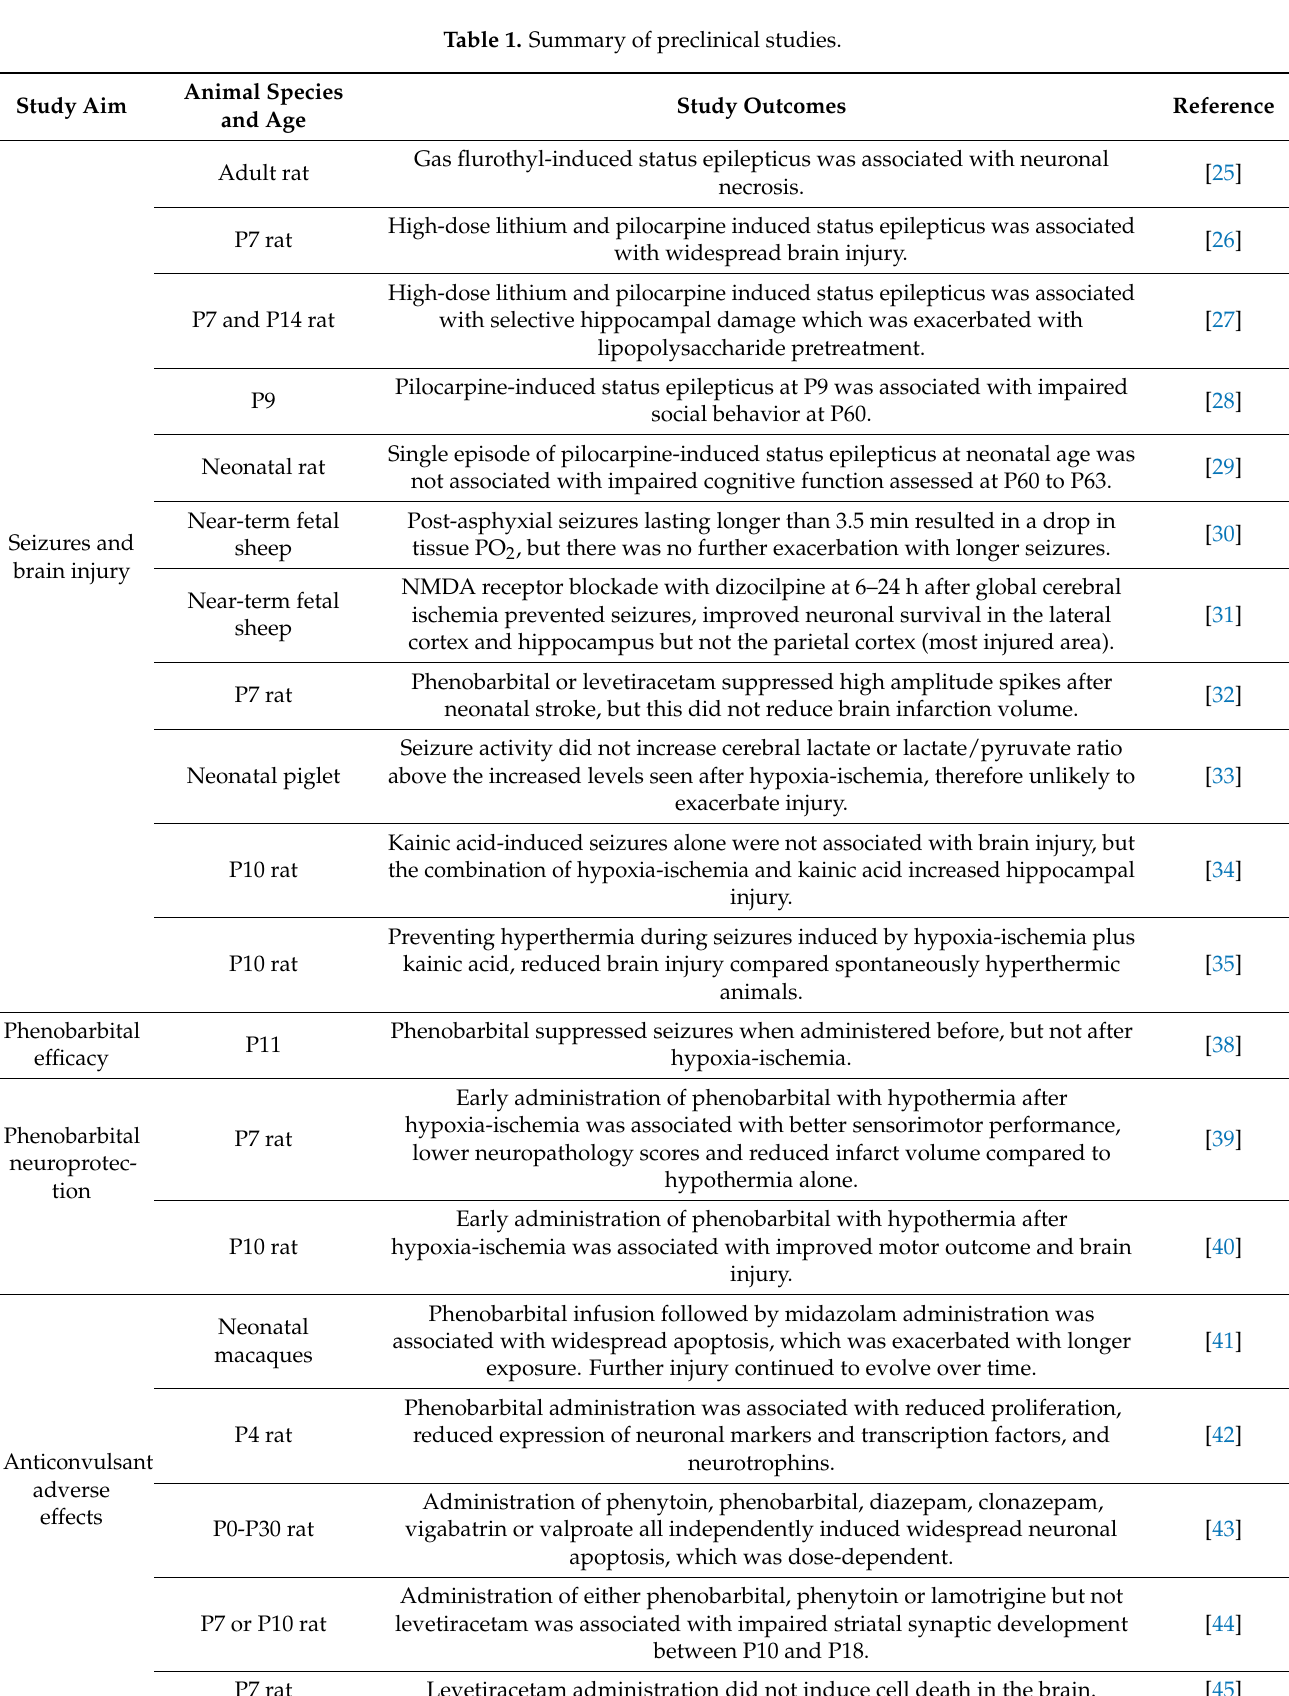
Table 1. Summary of preclinical